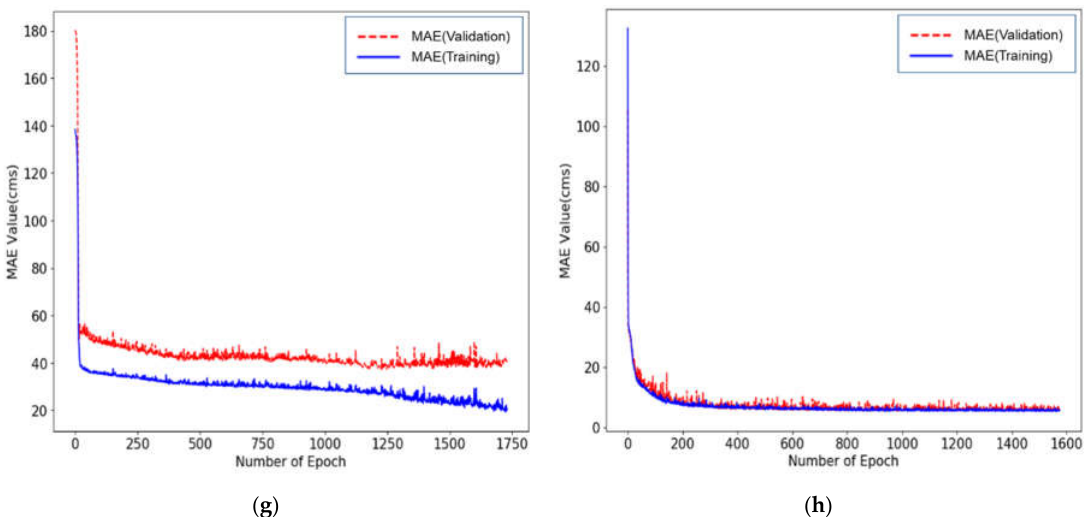
Figure 6. The trend of mean absolute error (MAE) with validation and testing data. ( a ) Shows Case 1: original data, ( b ) shows Case 1: after the 10th data augmentation, ( c ) shows Case 2: original data, ( d ) shows Case 2: after the 10th data augmentation, ( e ) shows Case 3: original data ( f ) shows Case 3: after the 10th data augmentation, ( g ) shows Case 4: original data and ( h ) shows Case 4: after the 10th data augmentation.